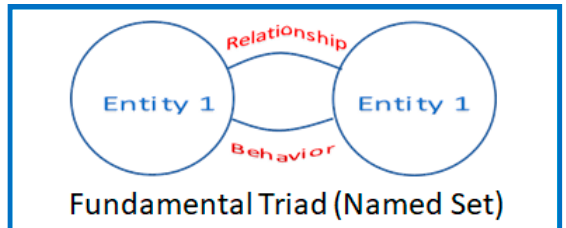
Figure 1. A named set or a fundamental triad can represent epistemic connections between two entities as a knowledge structure derived from